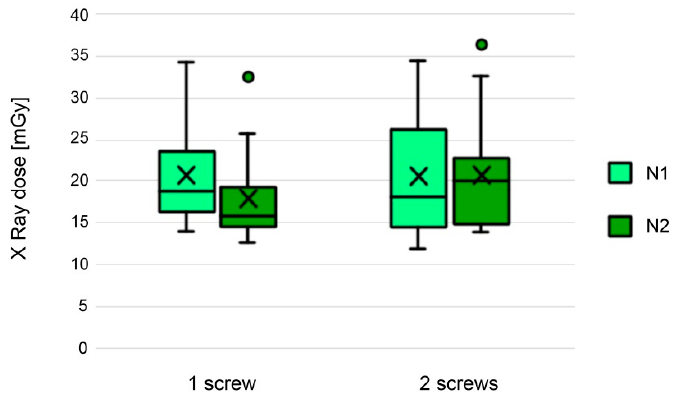
Figure 4. Box-and-whisker plot showing differences in the radiation doses depending on the num- ber of screws in group N1 and N2. (x—mean; line—median; box—first to third quartile; whiskers—minimum and maximum; dot—data outliers).